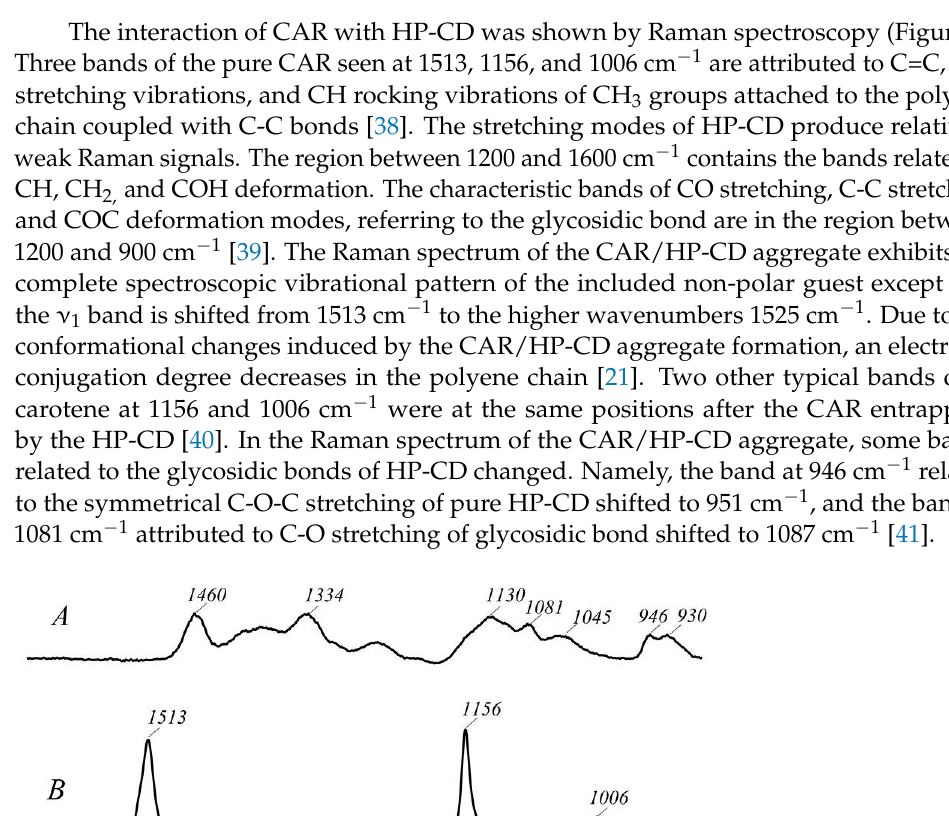
Figure 3. Samples of the CAR/HP-CD aggregates prepared at different concentrated aggregate dispersion of HP-CD and their VIS spectra.